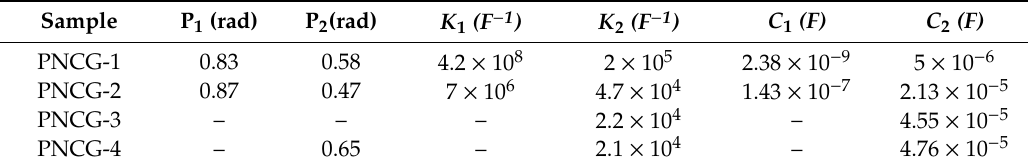
Table 3 signifies the fitting parameters in the EEC. Table 3. The electrical equivalent circuit(EEC) fitting parameters for polymer composite electrolytes (PCEs) system at room